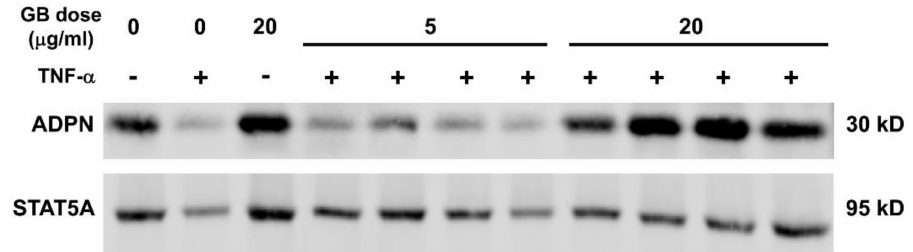
Figure 5. Groundsel bush attenuates TNF- α -induced repression of adiponectin expression in 3T3-L1 adipocytes. Fully differentiated 3T3-L1 adipocytes were treated daily with 0 (DMSO vehicle), 5 or 20 µ g/mL GB and 0.5 nM TNF- α (+ condition) or 0.1% BSA vehicle ( − condition). After three days, whole-cell extracts were isolated and used for Western blot analysis (50 µ g total protein per lane). Membrane was probed for STAT5A as a loading control. Four biological replicates are shown for the GB treatments in the presence of TNF- α